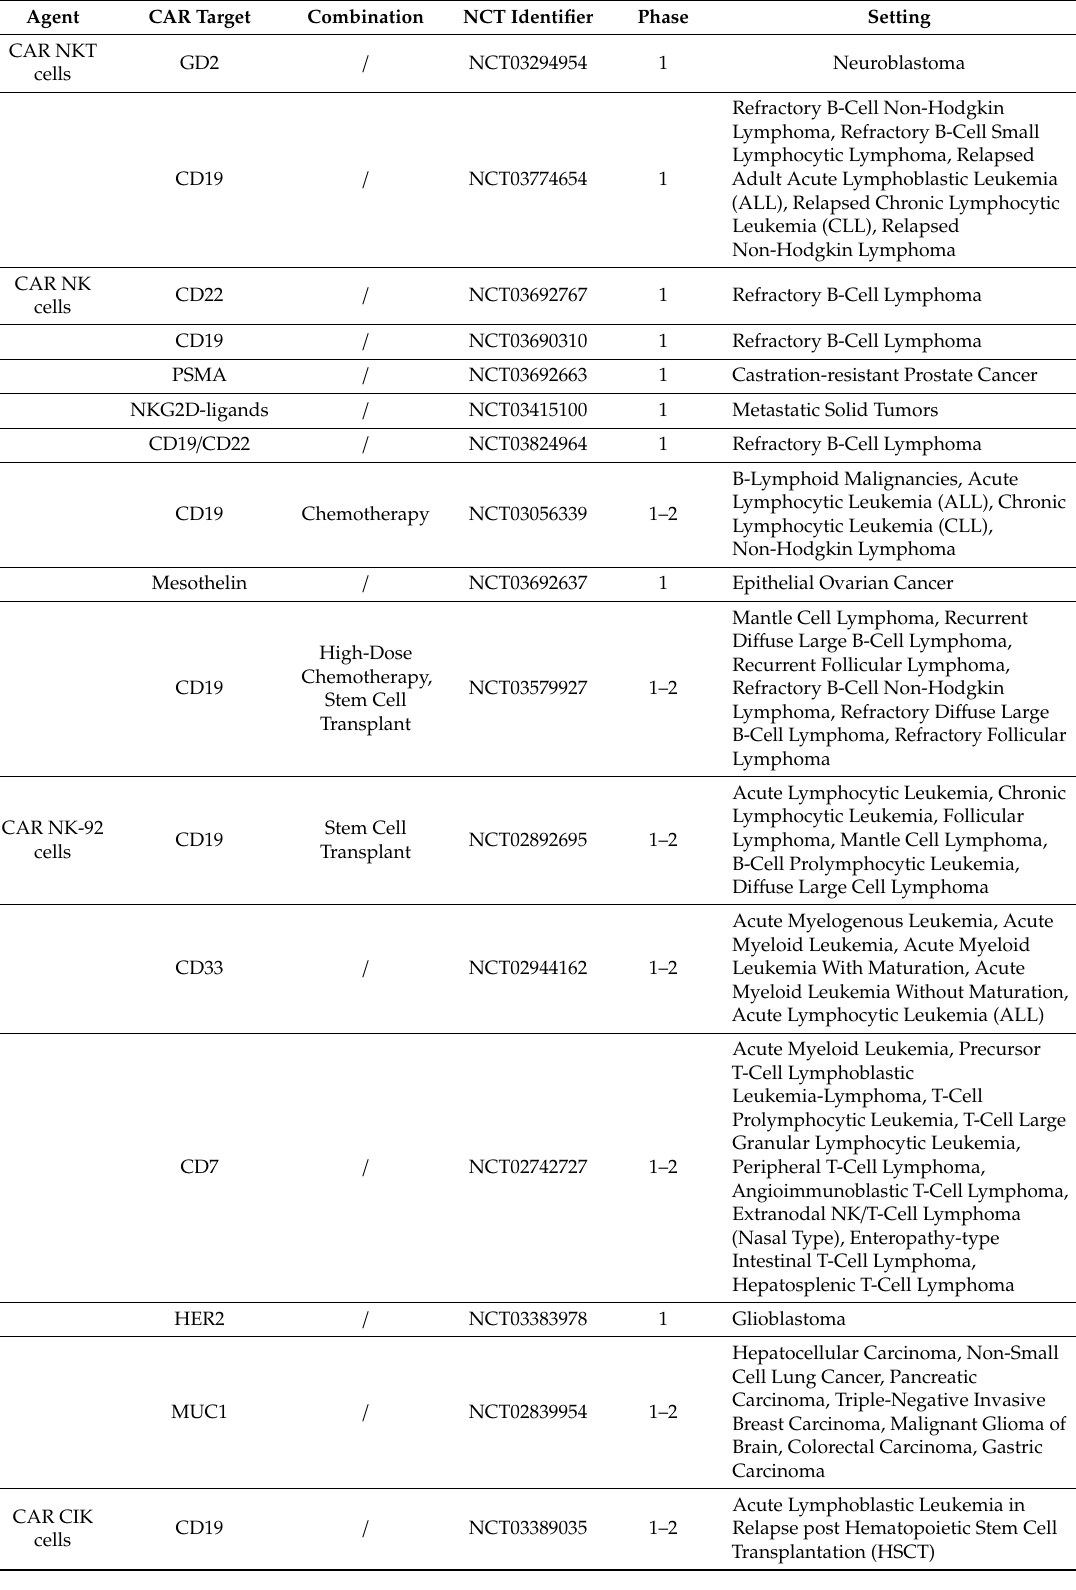
Table 1. Main ongoing clinical trials involving alternative cell types as platforms for CAR engineering. CAR, Chimeric Antigen Receptor; PSMA, prostate specific membrane antigen; HER2, erb-b2 receptor tyrosine kinase 2; MUC, mucin; NK, natural killer; CIK, Cytokine Induced